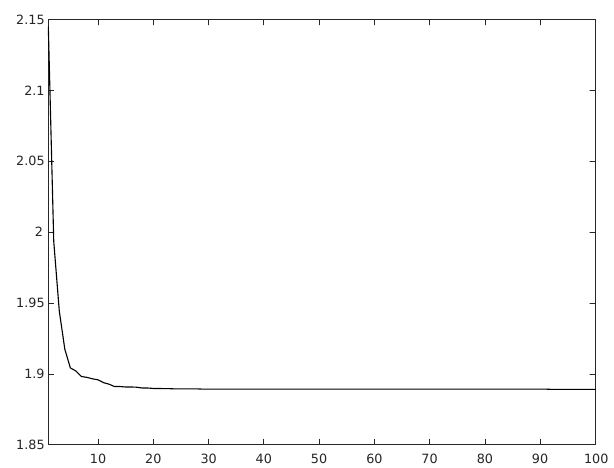
Figure 1: Approximated Optimal Control Figure 1. Approximated optimal control.